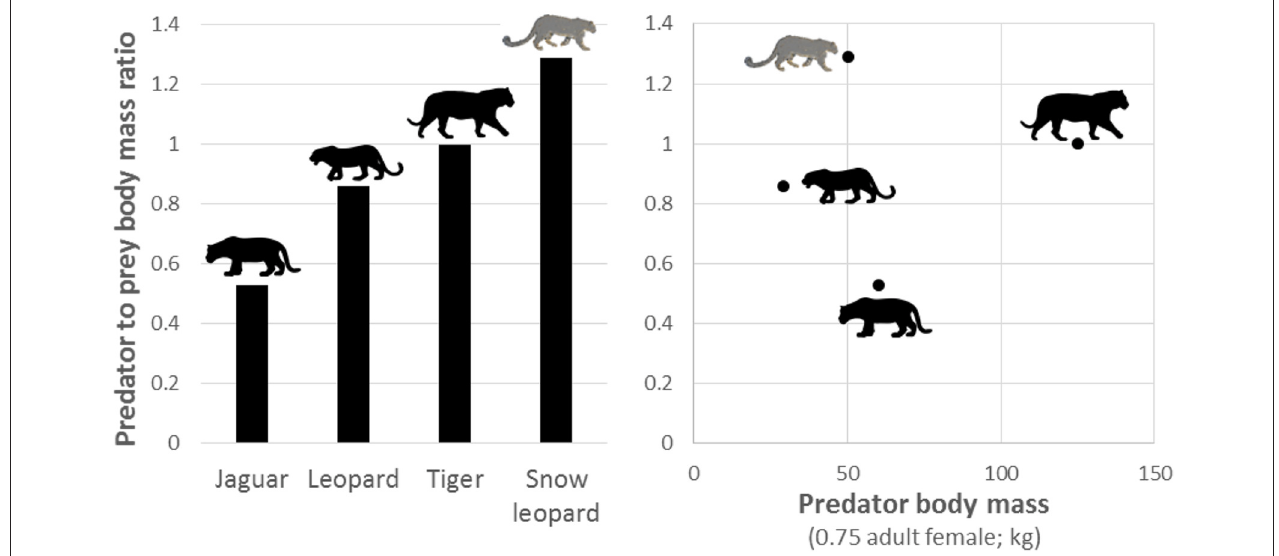
FIGURE 9 | Plot of the predator to prey body mass ratio of solitary members of the genus Panthera and how this relates to the body mass of each species (Hayward et al., 2006a, 2012; Lyngdoh et al.,